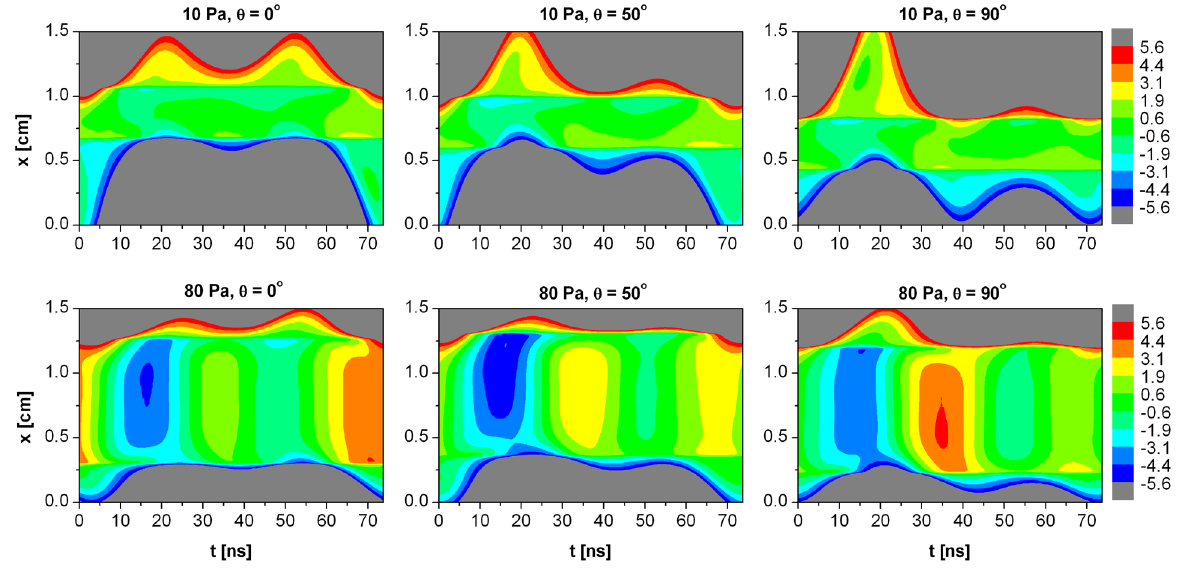
Figure 9 : Spatio-temporal distribution of the electric field in electrically asymmetric dual-frequency discharges operated at 13.56 MHz + 27.12 MHz for different values of the phase shift between the driving harmonics, θ, at 10 Pa, Φ Φ =Φ = 50 V (second row). The color scales are given in 10 3 Vm -1 and apply to all plots in the same row. LF HF